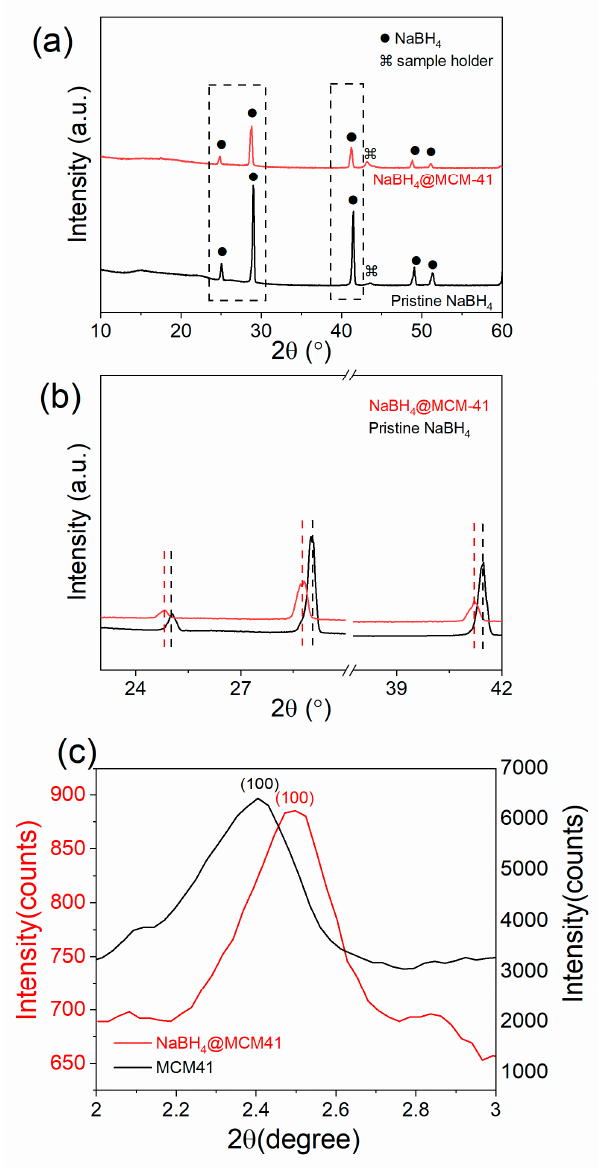
Figure 1. ( a ) X-ray diffraction (XRD) of nanoconfined NaBH 4 along with that of pristine NaBH 4 and ( b ) magnification of ( a ) for 2 θ = 23–42°; ( c ) small angle XRD of MCM-41 and NaBH 4 @MCM- 41.